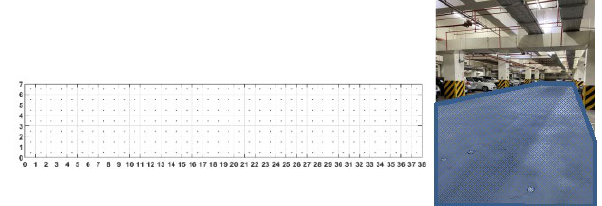
Figure 12. The illustration of grid division and the photo of experimental field